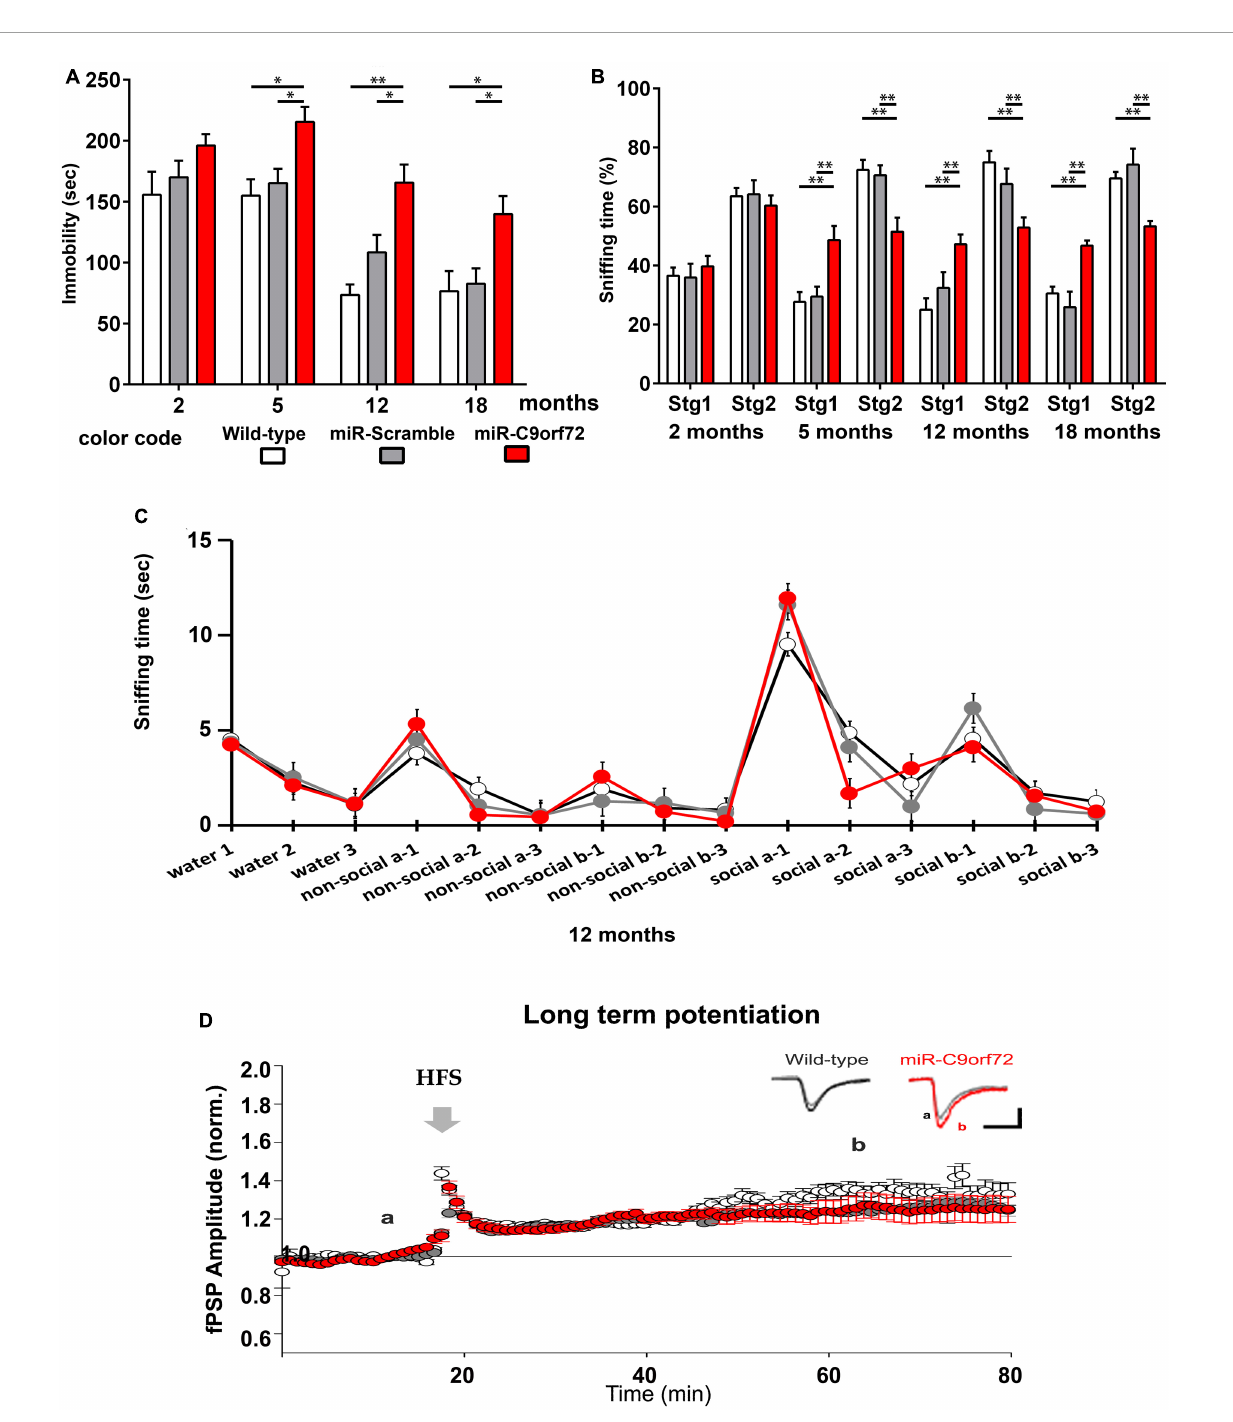
FIGURE4 miR-C9orf72 mice develop FTD-like behaviors. (A) Forced swim assessment for depression-like behavior at 2, 5, 12, and 18 months (wild-type n = 10; miR-Scramble n = 12, miR-C9orf72 n = 34). Depression-like behavior is measured as the time of immobility in the water tank. (B) Three-chamber test for social interaction and social novelty at 2, 5, 12, and 18 months (wild-type n = 10; miR-Scramble n = 12, miR-C9orf72 n = 34). Social exploration is quantified as time spent sniffing an already known mouse (stg1) or a novel mouse (stg2). (C) Olfactory habituation/dishabituation test at 12 months used to measure if animals can differentiate between same and different odors, social and non-social. For all mice, consecutive presentations of the same odor resulted in decreased investigation of the smell showing habituation. Sniffing time increased again each time the subject was introduced to a new smell and social cues elicited a higher response than non-social ones as expected demonstrating normal olfaction and memory (wild-type n = 6; miR-Scramble n = 6, miR-C9orf72 n = 7). (D) Study of long-term potentiation in the CA1 area. High frequency stimulation (HFS; 2 × 100 Hz, 1 s) of CA3 Schaffer collaterals induced a long-term potentiation (LTP) of the CA1 post-synaptic field potential (fPSP) in all animals tested. The LTP amplitude was similar between the miR-C9orf72 and control animals. At the top right, representative sample traces from an electrode before (gray) and after the LTP induction in the miR-C9orf72 (red) and the WILD-TYPE (black) (wild-type n = 6; miR-Scramble n = 6, miR-C9orf72 n = 7). Error bars represent SEM; ∗ p < 0.05, ∗∗ p <